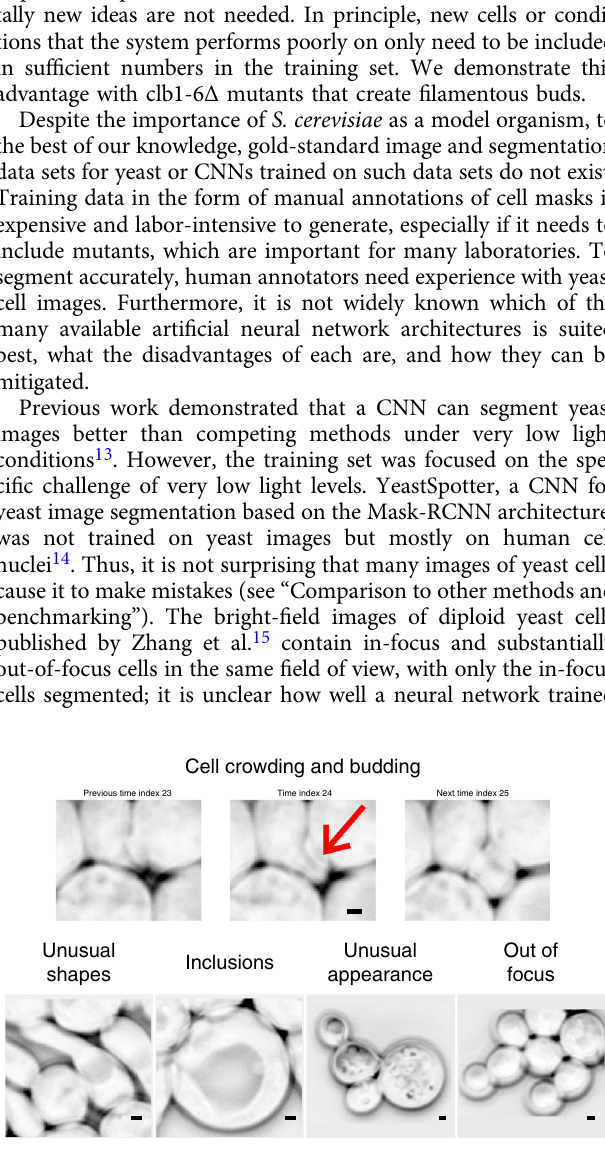
Fig. 1 Challenging cases for the segmentation of yeast images. The red arrow points to a dif fi cult-to-see new bud that appears in a timelapse movie. Scale bar: 1 μ m. Phase contrast images inverted for better visualization.